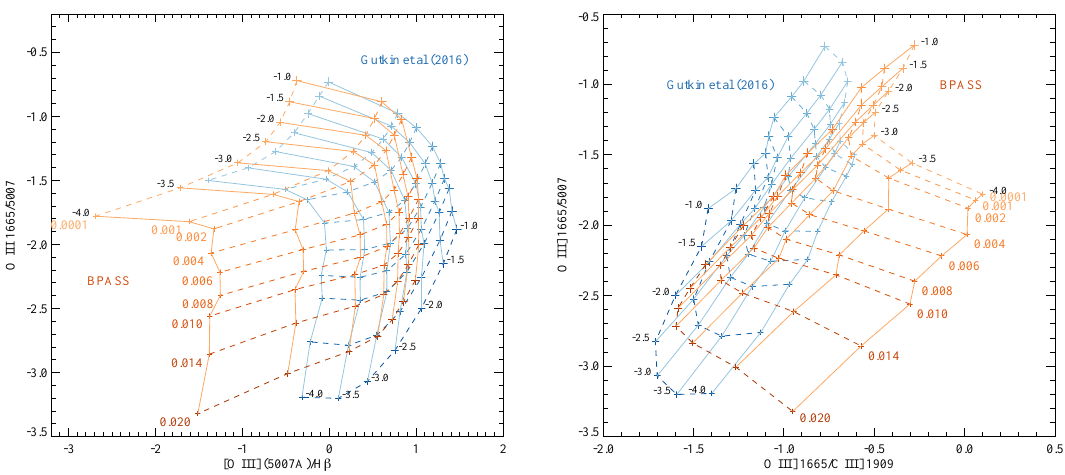
Figure 4. The effects of these stellar population choices on diagnostic diagrams. Models compared were the BPASS models as before (orange) and the nebular synthesis models of Gutkin et al. [142] (blue, based on the 2016 version of the GalaxEv models of BC03). BPASS models assume a broken power law IMF, with an upper slope of − 1.35 and an upper mass cut-off at 300M (cid:12) , while the nebular gas electron density is 300 cm − 3 . The Gutkin et al. [142] model assumes an IMF with the same slope and upper mass limit, but a Chabrier [60] lower mass cut-off for n e = 100 cm − 3 , [C/O] = 1 and a dust-to-metal ratio of 0.5. Both models assume constant star formation and are shown at matched metallicities. The flux in the ultraviolet doublets was summed before ratios were taken. The primary difference was in the handling of stellar evolution and